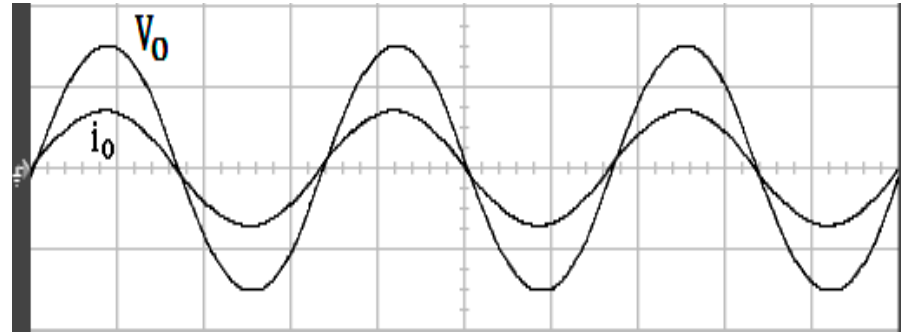
Figure 8. Output voltage and current for experiment of the proposed solution at full load (vertical: 100 V/div and 20 A/div; horizontal: 5 ms/div).